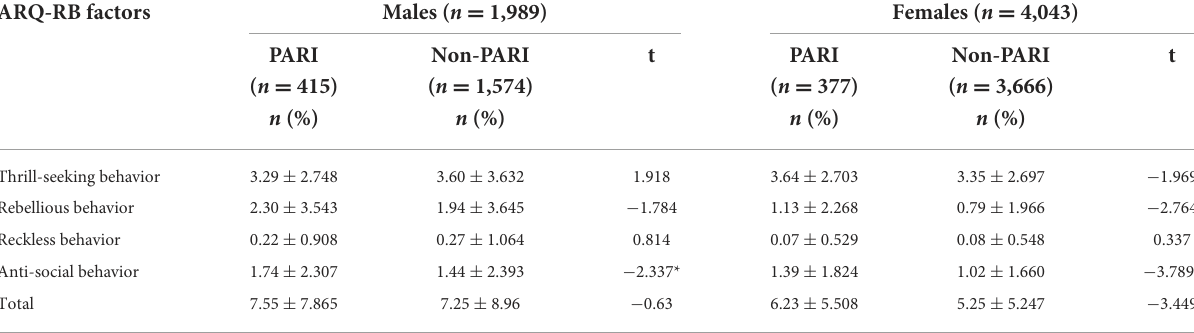
TABLE 3 Contrast of ARQ-RB scores of college students with PARI and non-PARI by gender. ARQ-RB factors Males ( n =